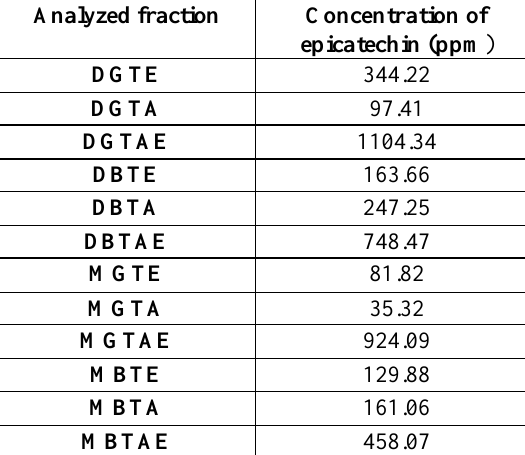
Figure 10. HPLC Calibration curve of epicatechin Table 5. The concentration of epicatechin in ethyl acetate fractions of green and black